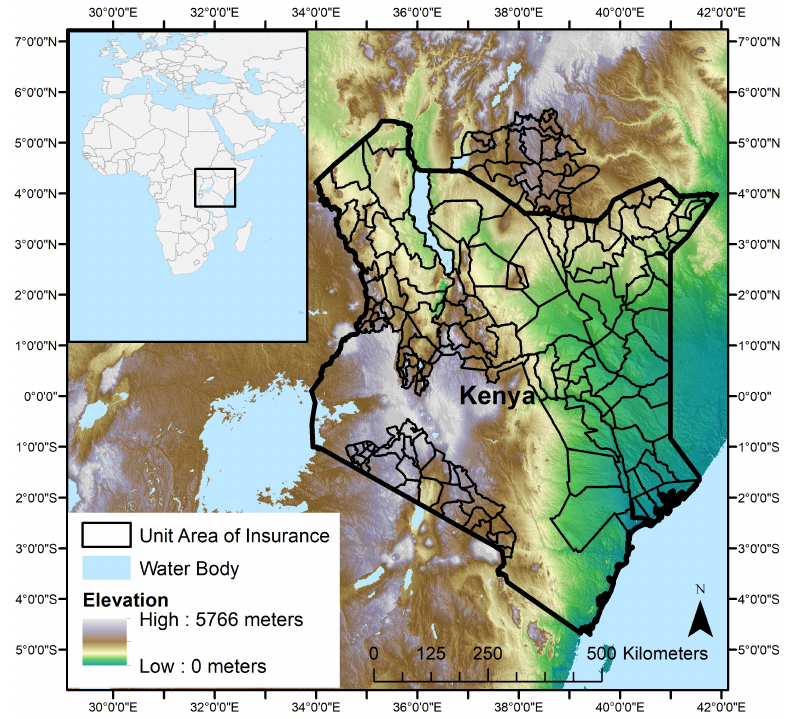
Figure 1. Study area showing the elevation from the Shuttle Radar Topography Mission [30] and Unit Areas of